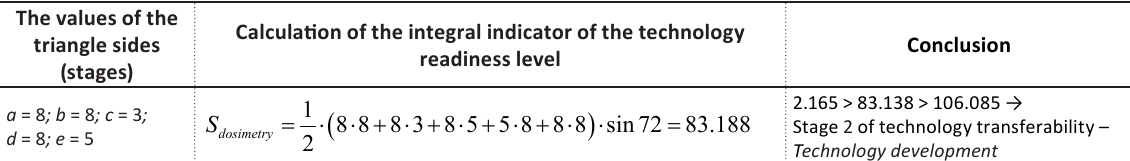
Table 3. Determination of the stage of OSL dosimetry IR technology transferability using the method of geometric construction